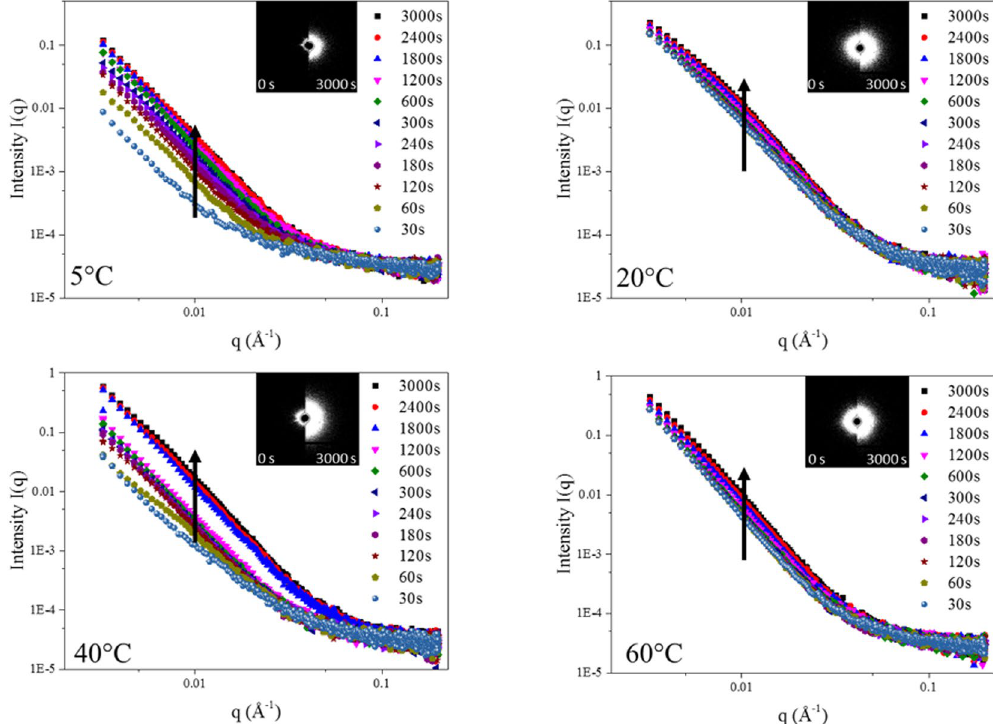
Figure 3. Raw data curves of in-situ SAXS dealloying test at 5 °C, 20 °C, 40 °C and 60 °C. The insets show the typical scattering patterns corresponding to the beginning and the end and highlighting the change in the distribution of the scatters. The arrow represents the intensity increase with increasing duration.